Question: Provide a publication-style caption for this figure.
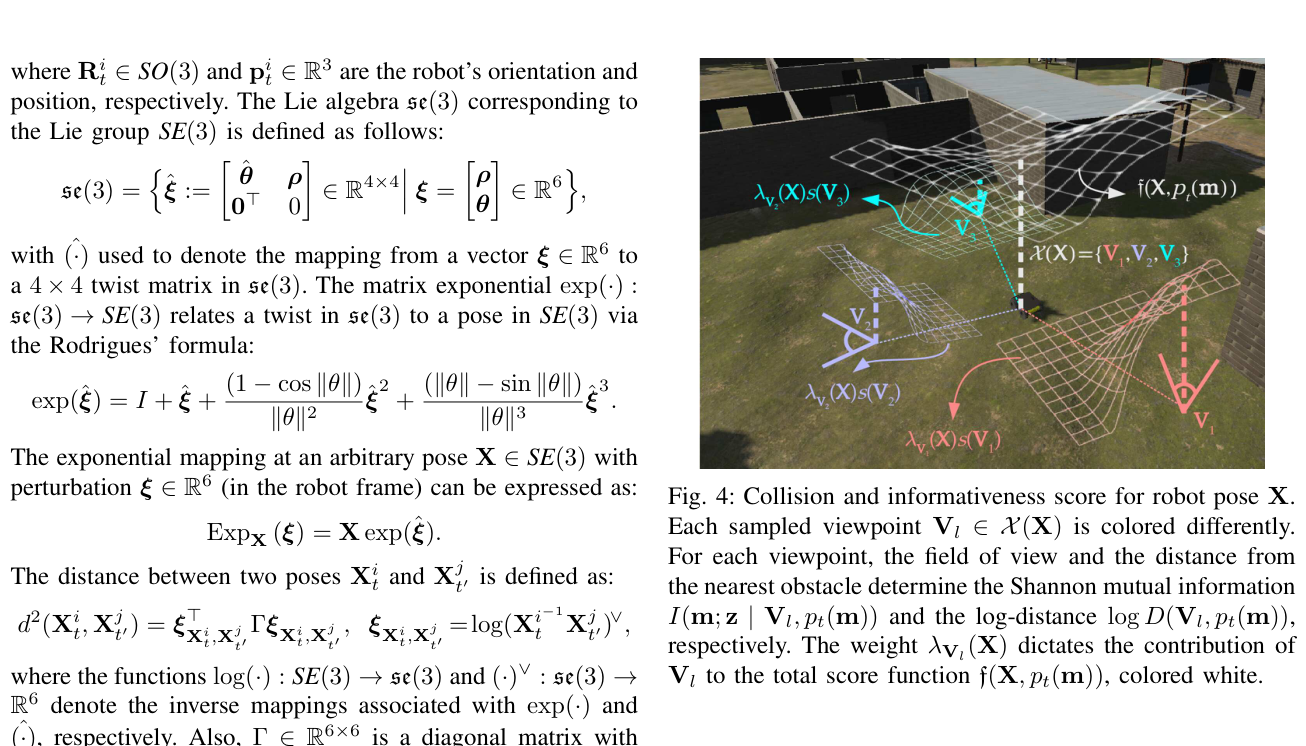
Answer: Collision and informativeness score for robot pose X. Each sampled viewpoint Vl ∈X(X) is colored differently. For each viewpoint, the field of view and the distance from the nearest obstacle determine the Shannon mutual information I(m; z | Vl, pt(m)) and the log-distance log D(Vl, pt(m)), respectively. The weight λVl(X) dictates the contribution of Vl to the total score function f(X, pt(m)), colored white.